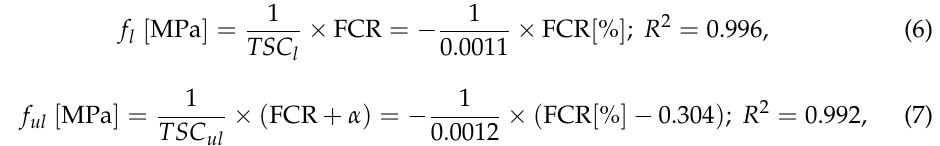
Table 7. Electromechanical parameters of the SCA under the tensile stress of strands.